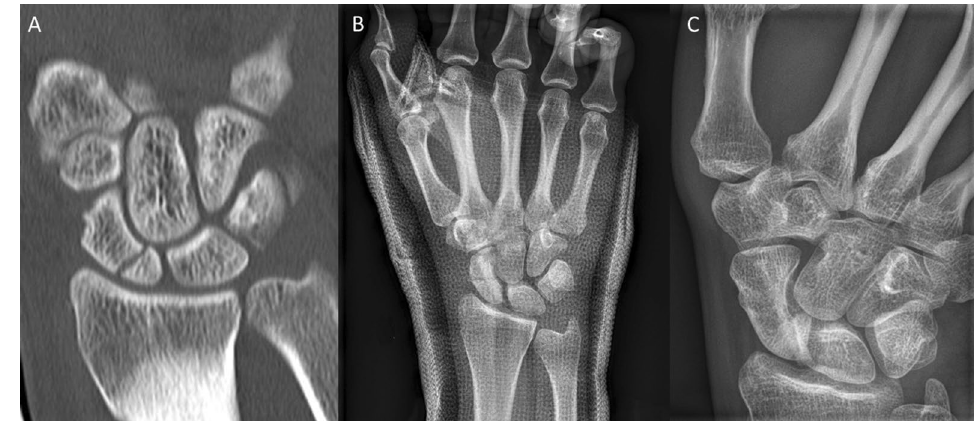
Fig. 3 Fresh scaphoid fracture in the proximal pole. A Pre-surgery. B 1 day post-surgery. C 12 months post-surgery